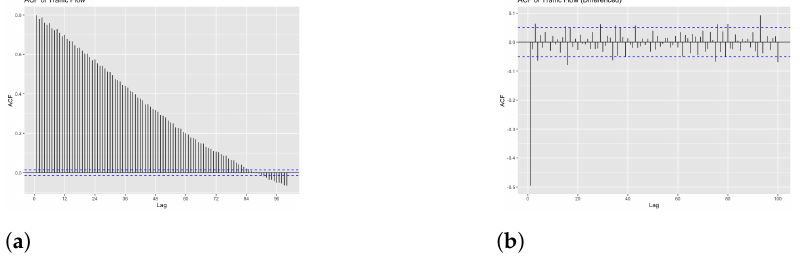
Figure 22. Autocorrelation functions of generated data. ( a ) ACF of generated traffic Data. ( b ) ACF of differenced data.